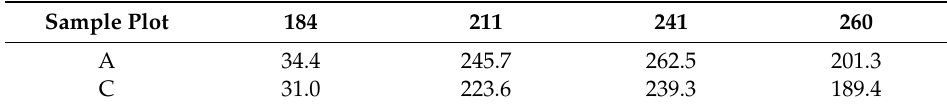
Table 2. Measured dry weight of rice roots (WRT) in the sample plots in the two study areas on four acquisition dates (DOY), unit of WRT is g/m 2 Sample Plot 184 211 241 260 A